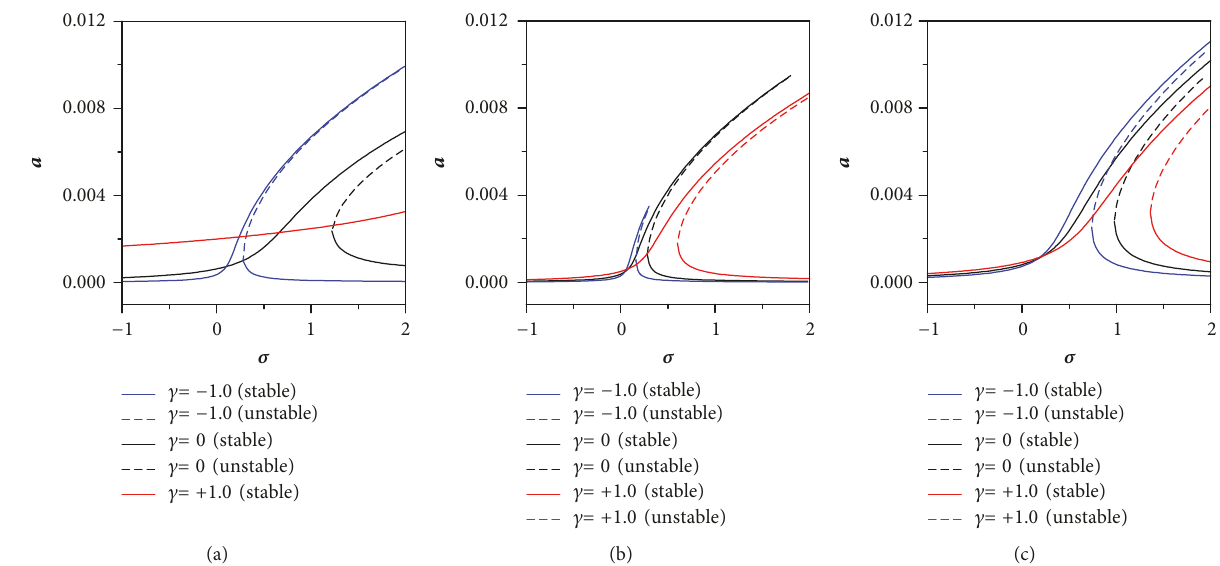
Figure 7: Frequency response curves of super harmonic resonances: (a) hinged-hinged; (b) hinged-fixed; (c)